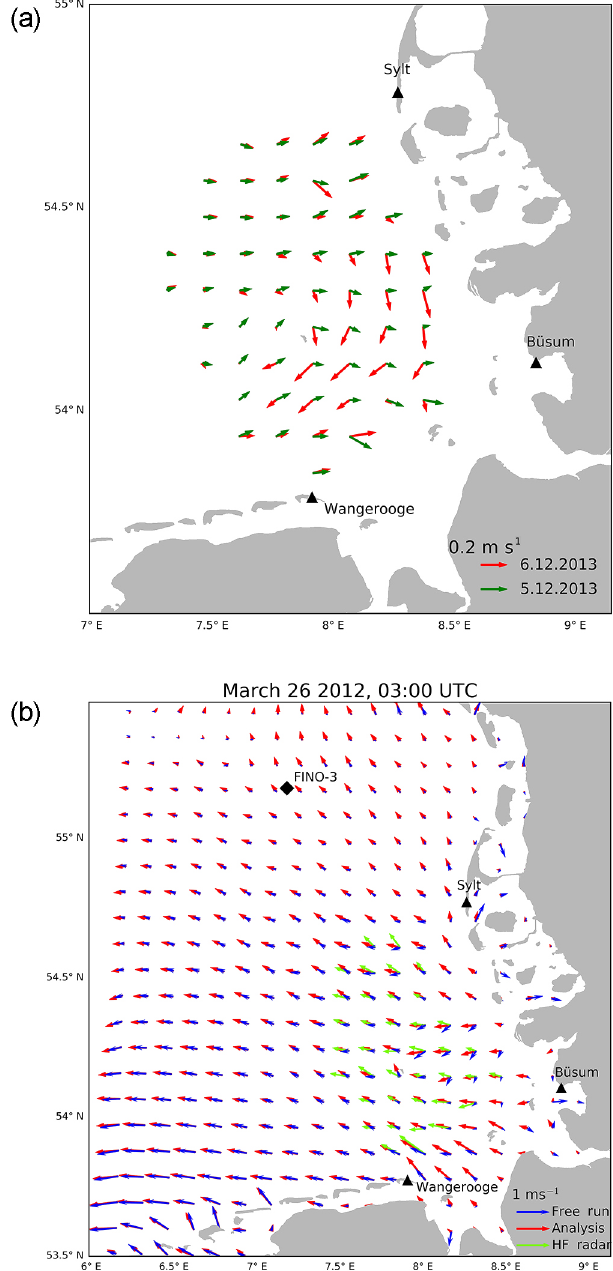
Figure 9. Surface currents in the German Bight. (a) De-tided cur- rents as seen by the HF radars during the period when storm “Xavier” was over the German Bight. The positions of the arrows illustrate the area covered by HF radar observations. This area is smaller than the model area. (b) Simulated and observed surface currents. The green arrows represent the HF radar measurement (not over the entire model area), the blue arrows are based on the free model run, and the red arrows are the analysis. The positions of the three HF radar stations are given with the triangle symbols; the diamond shows the position of the FINO-3